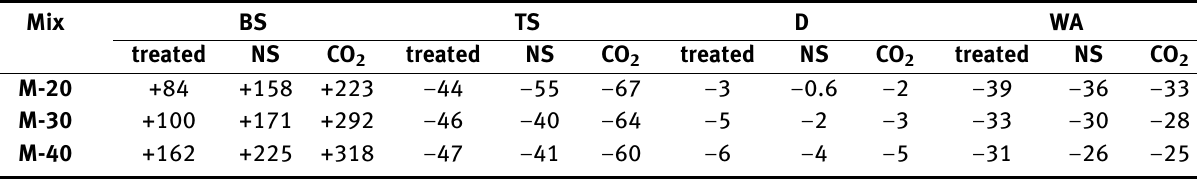
Table 4: Parameters sensitivity analysis as compared to untreated specimens. Mix BS TS D treated NS CO 2 treated NS CO 2 treated M-20 +171 M-40